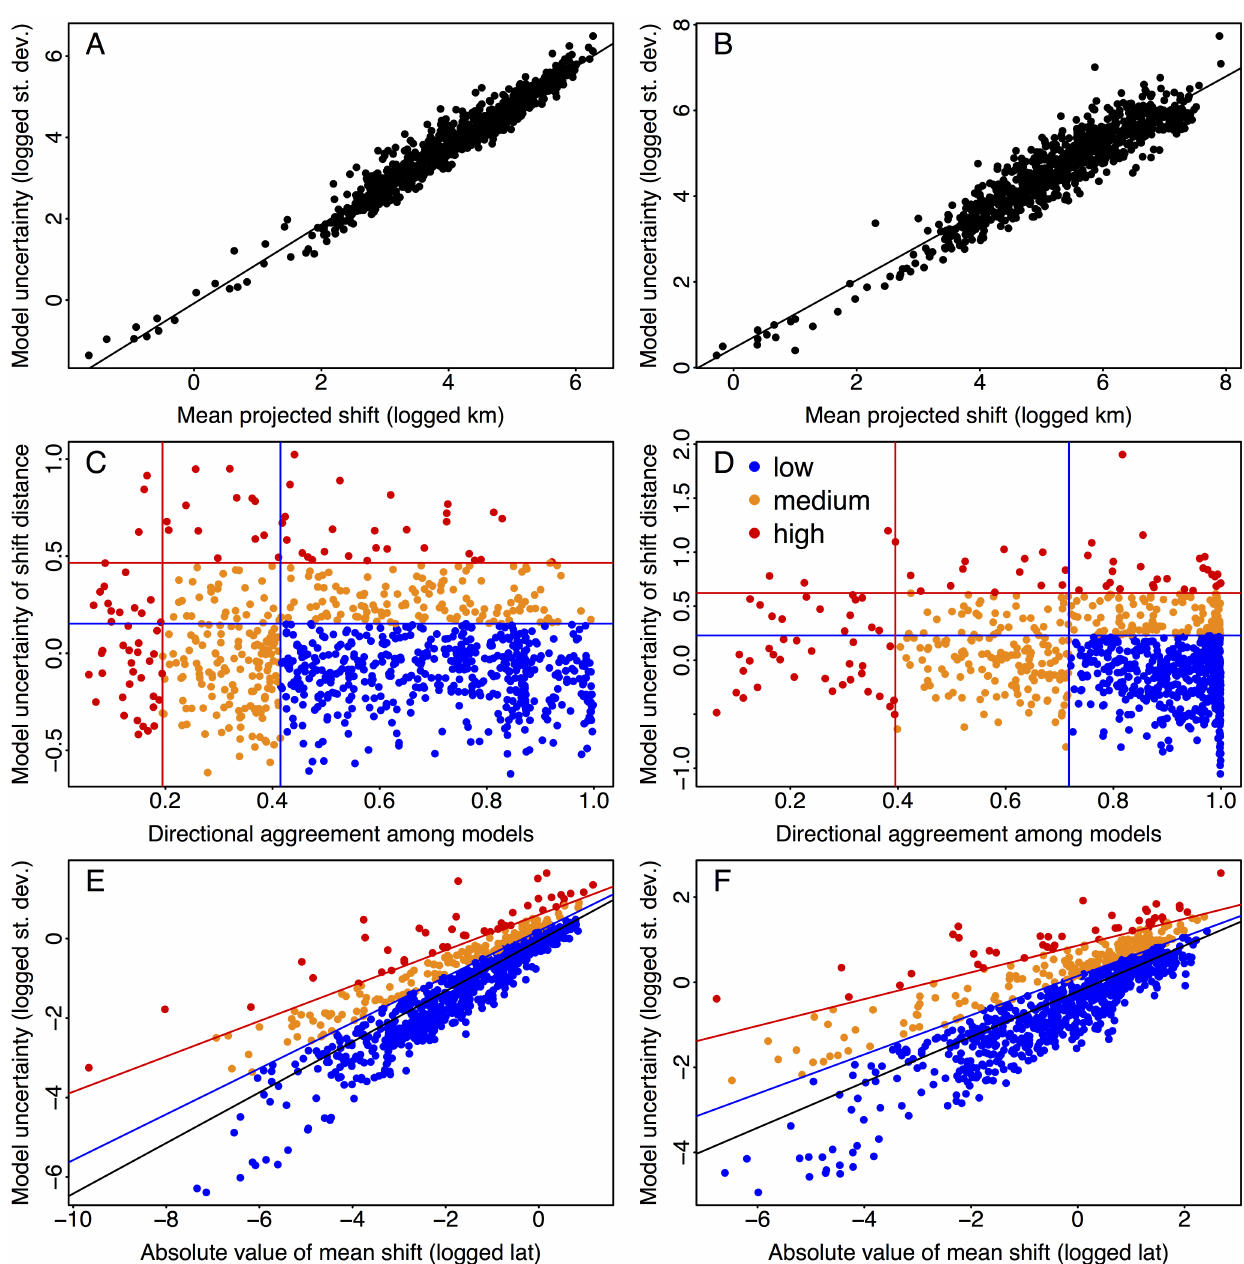
Fig 2. Species projection uncertainty. Categorizing uncertainty for 878 species projections within the RCP 2.6 (A, C, and E) and RCP 8.5 (B, D and F) scenarios. (A and B) The logged standard deviation of projected shift distance plotted against the logged mean shift distance in km among 16 GCMs. (C and D) The distance-directional uncertainty (DDU) method where the residual error values from panels (A) and (B) were plotted against shift directional agreement among GCMs. (E and F) The latitudinal uncertainty (LU) method where the logged standard deviation in projected shift in latitude was plotted against logged mean shift in latitude among 16 GCMs. Red and blue lines indicate the 95 th and 75 th percentiles (C and D) or quantiles (E and F), respectively. Points are colored according to their level of uncertainty where red indicates high uncertainty, orange is medium, and blue is low uncertainty